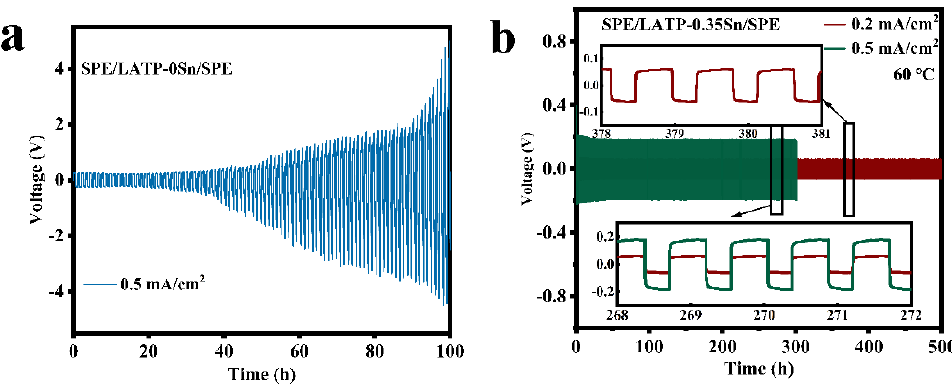
Figure 7. Voltage of the Li||Li symmetrical cells with ( a ) SPE/LATP-0Sn/SPE at the current density of 0.5 mA/cm 2 and ( b ) SPE/LATP-0.35Sn/SPE at the current density of 0.2 mA/cm 2 and 0.5 mA/cm 2 .